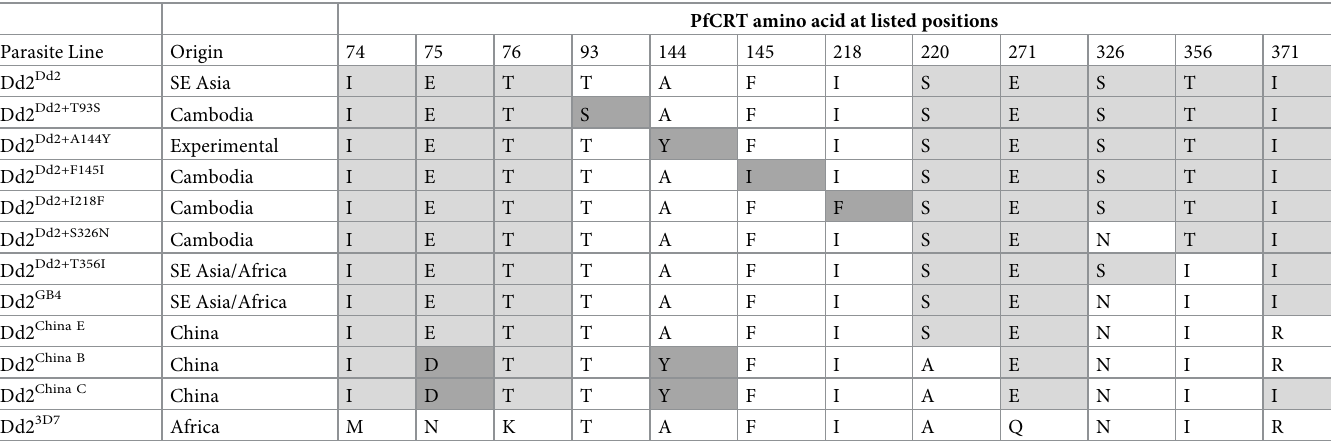
Table 1. Parasite lines used in this study. Parasite